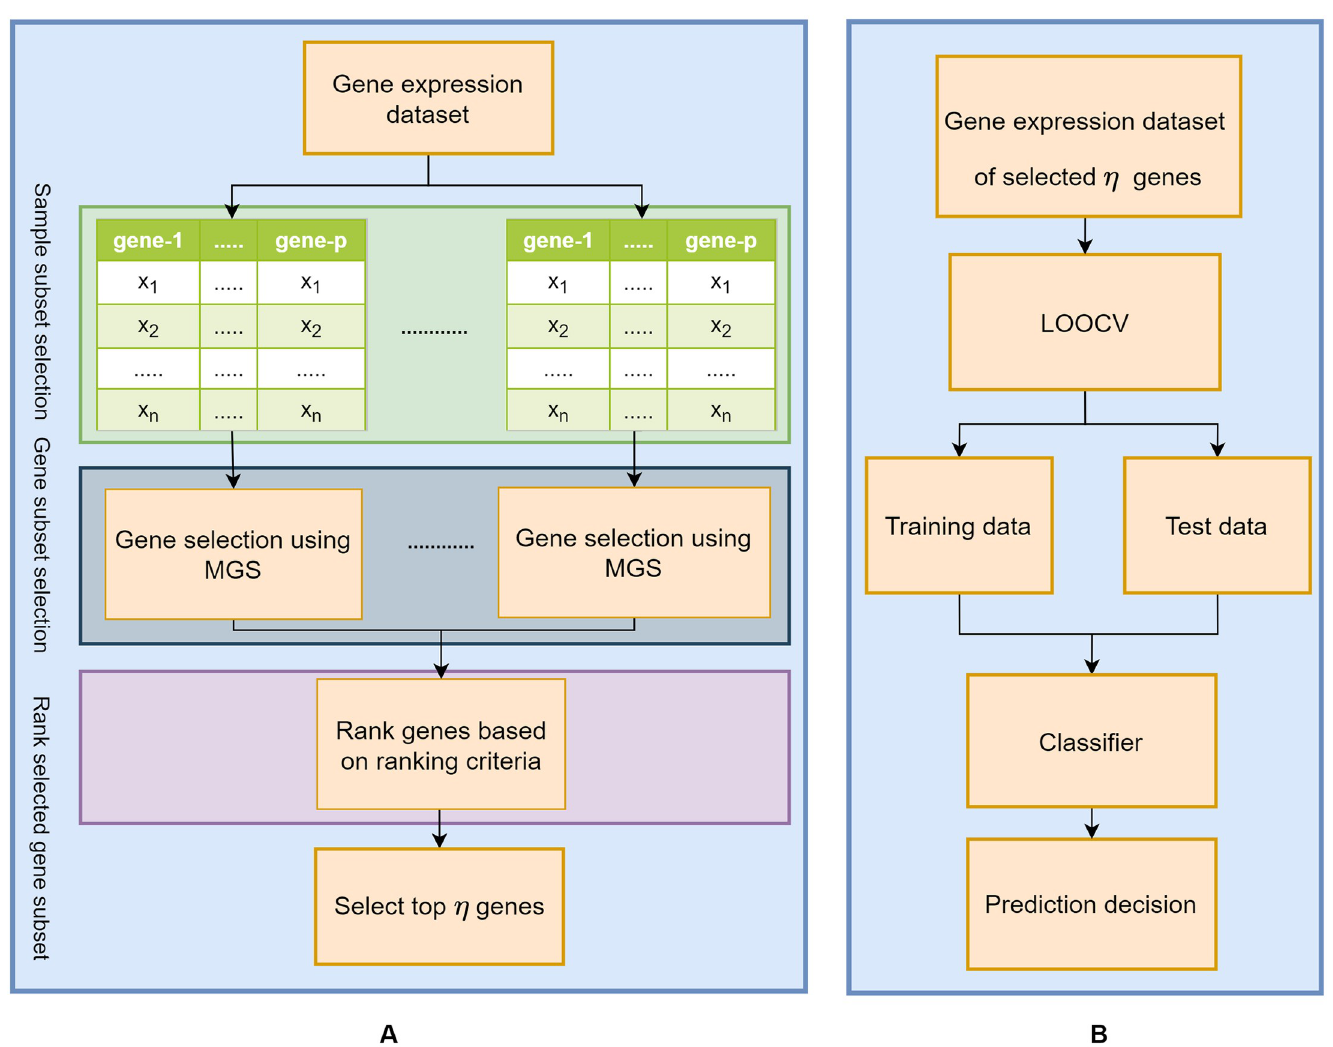
Fig 1. Overall process of the proposed method. (A) Gene selection. (B)